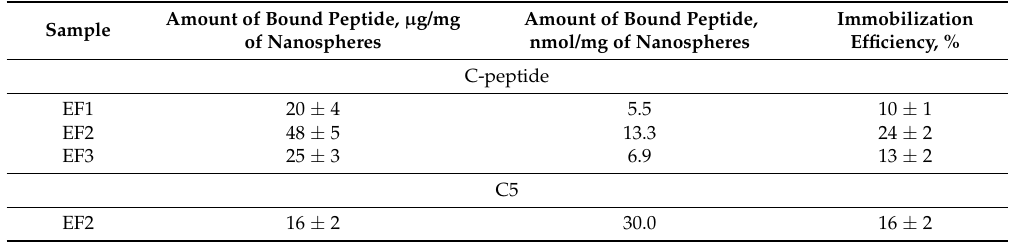
Figure 5. Scheme of covalent modification of P(Glu- co - D Phe) particle surface. Table 3. Characteristics of nanospheres under C-peptide and C5 covalent immobilization. Conditions of immobilization : 0.01 M PBS, pH 7.4; 22 ◦ C; 2